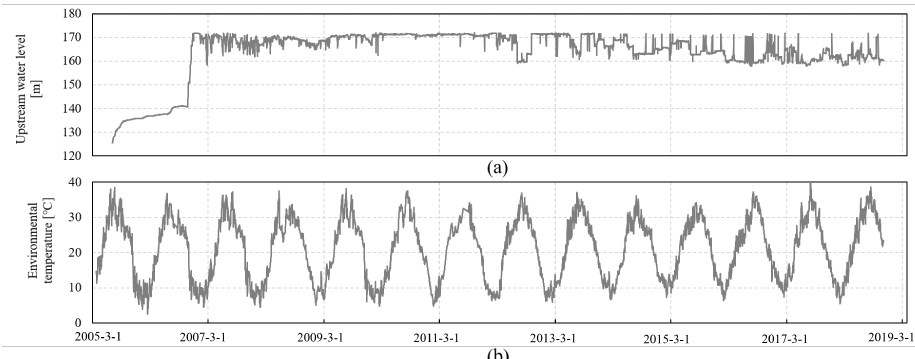
Figure 7. Ambient data series of Langyashan dam: ( a ) upstream water level, ( b ) environmental